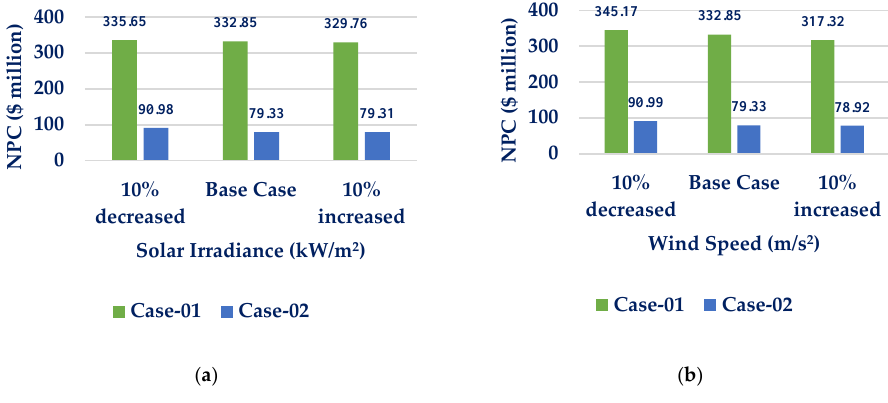
Figure 26. Impact on NPC due to variation in ( a ) solar irradiance; ( b ) wind speed.